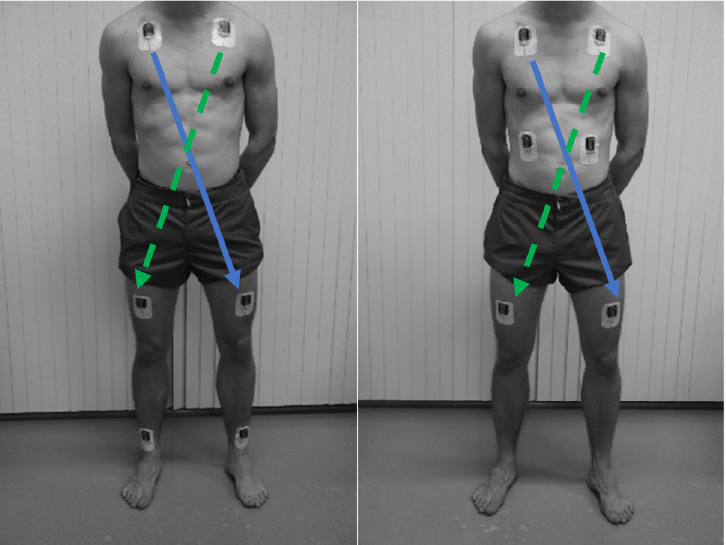
Figure 1. Pictures showing the accelerometer locations, with the blue arrows indicating the midclavicular line right-thigh left (MCR-TL) and green (dotted) arrows indicating the midclavicular line left-thigh right (MCL-TR) configuration used in the present study.